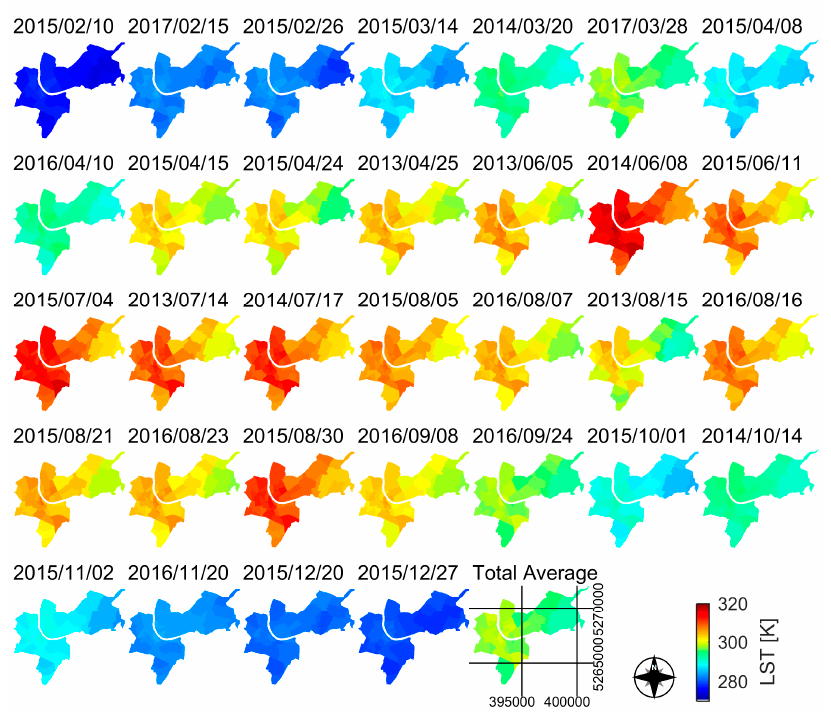
Figure 5. LST averages retrieved from L8 TIRS of each residential district for 32 days between 2013 and 2017 of the Canton Basel-Stadt. The scenes are ordered after the DOY of acquisition.